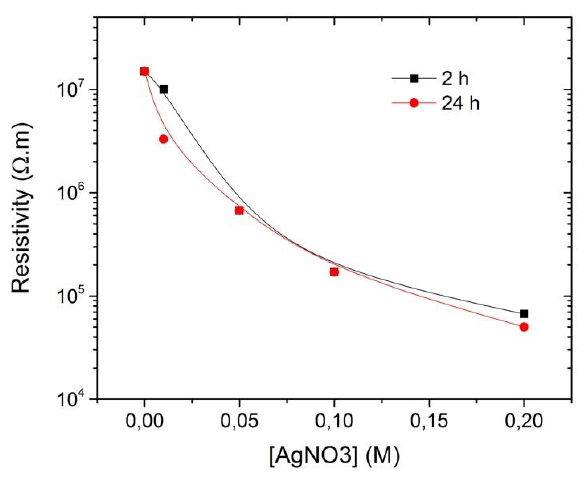
Figure 2. Graphic demonstrating the resistivity values dependence on the precursor concentration. 243 As referred before, the main goal of this work was to decrease the resistivity values of jute fabric 244 with the functionalization of Ag NPs. Hence, all the modifications in the synthesis protocols were 245 made accordingly with the values obtained for resistivity. As it can be observed in Table 1, using the 246 UV method, several samples were obtained utilizing 4 different concentrations from 0.01 M to 0.2 M; 247 were irradiated each side from 5h to 10h. From the Jute sample to the JUV4 (0.2 M) the resistivity 249